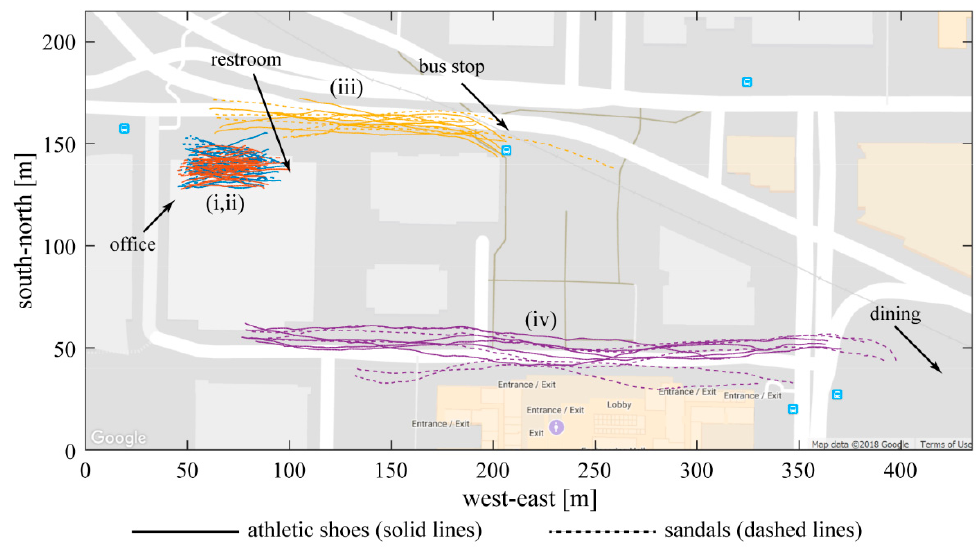
Figure 6. Frequently-repeated straight walking trajectories found from a 10-day walking test. The subject wore athletic shoes and sandals for 5 days each, indicated by solid lines and dashed lines respectively. Matched colors indicate clustered paths with at least 300 strides over at least three days in each condition. These paths all occurred within the green box at the bottom of Figure 5, near the labeled features (colors are changed for greater contrast). Blue and red lines (i,ii) are walking trajectories in the hallway between the subject’s office and the restroom and water fountain (different directions are separated into two different paths). Yellow lines (iii) represent the sidewalk between the building where the subject works and a nearby bus stop. Purple lines (iv) represent a sidewalk between the same building and a dining location.